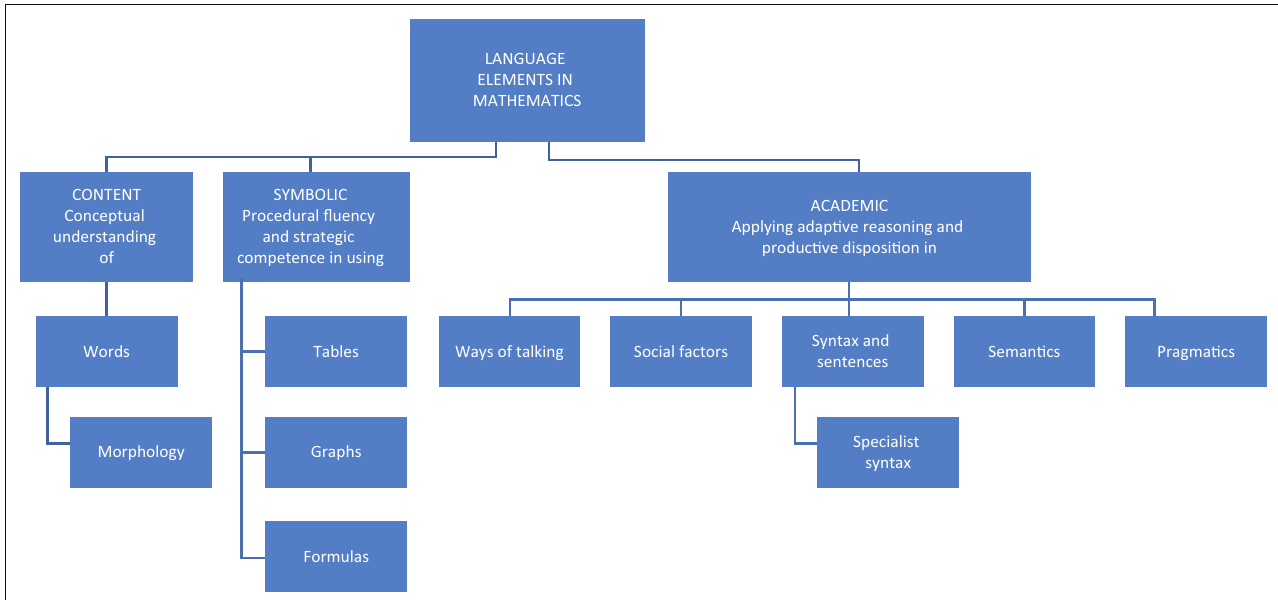
FIGURE 1: Types of language in